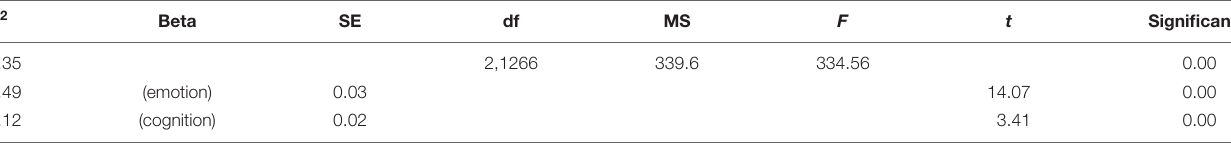
FIGURE 2 | Mean emotion and cognition in place identity as a function of high vs. low naturalness in urban greenery. TABLE 2 | Regression statistics for the relation between place identity (emotion and cognition components) and wellbeing. R